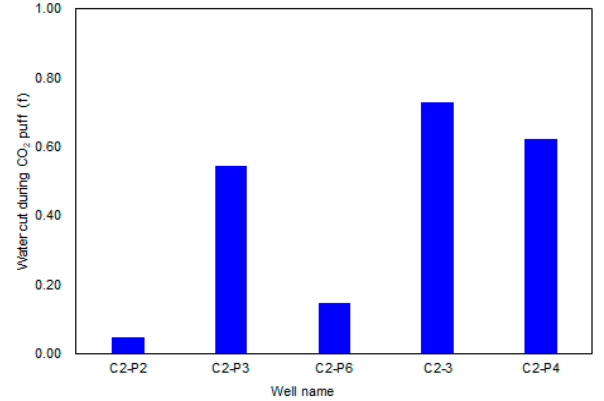
Figure 36. Average water cut before and after huff and puff.